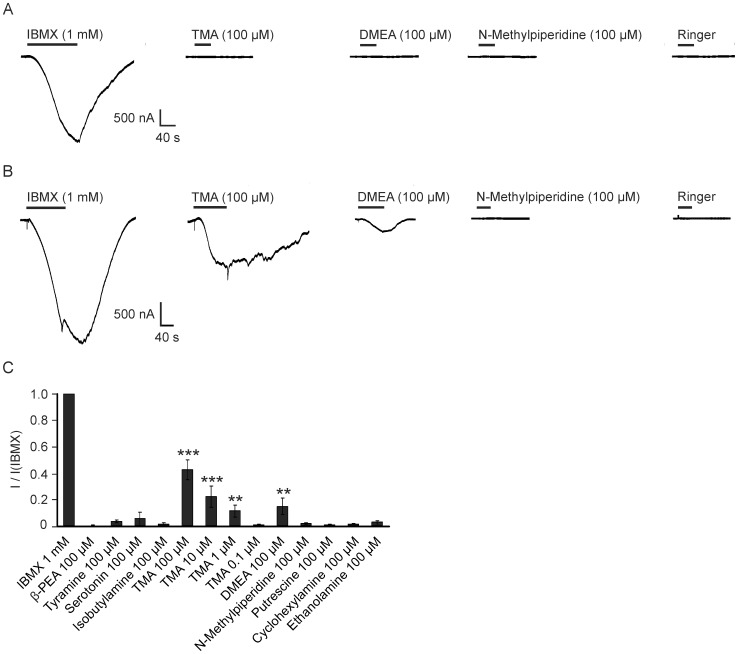
TMA and DMEA activate hTAAR5 expressed in Xenopus oocytes. A:IBMX induced currents in oocytes expressing the reporter channel CFTR only. B: In oocytes injected with hTAAR5 cRNA application of TMA and DMEA as well as IBMX as positive control generated currents. C: Test substance induced currents normalized to the corresponding IBMX response. TMA and DMEA induced currents significantly differing from Ringer control (***p<0.001; **p<0.01). Evoked currents were measured by two-electrode voltage clamp technique at a holding potential of −70 mM. Black bars indicate time of agonist application. Error bars represent SEM.